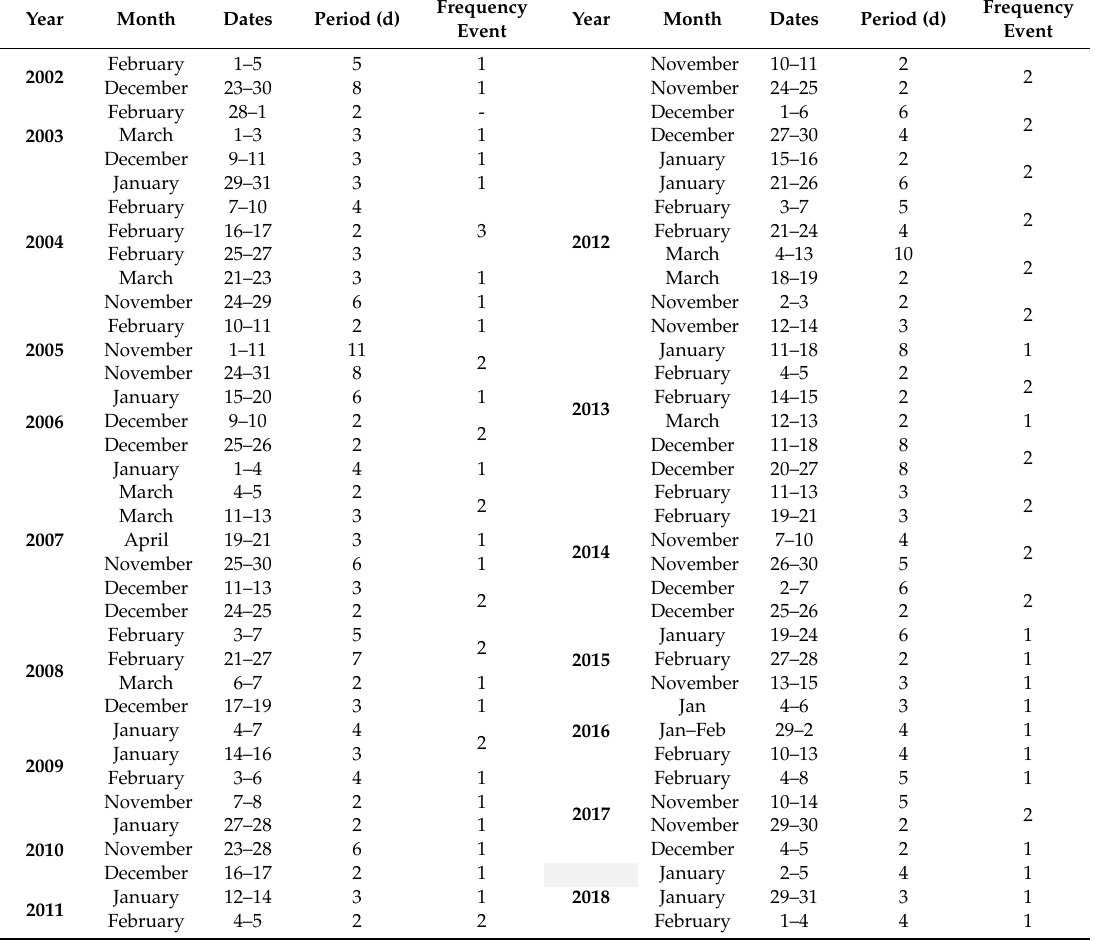
Table 3. Statistics of occurrence of whiting in the Gulf for 16 years (July 2002 to July